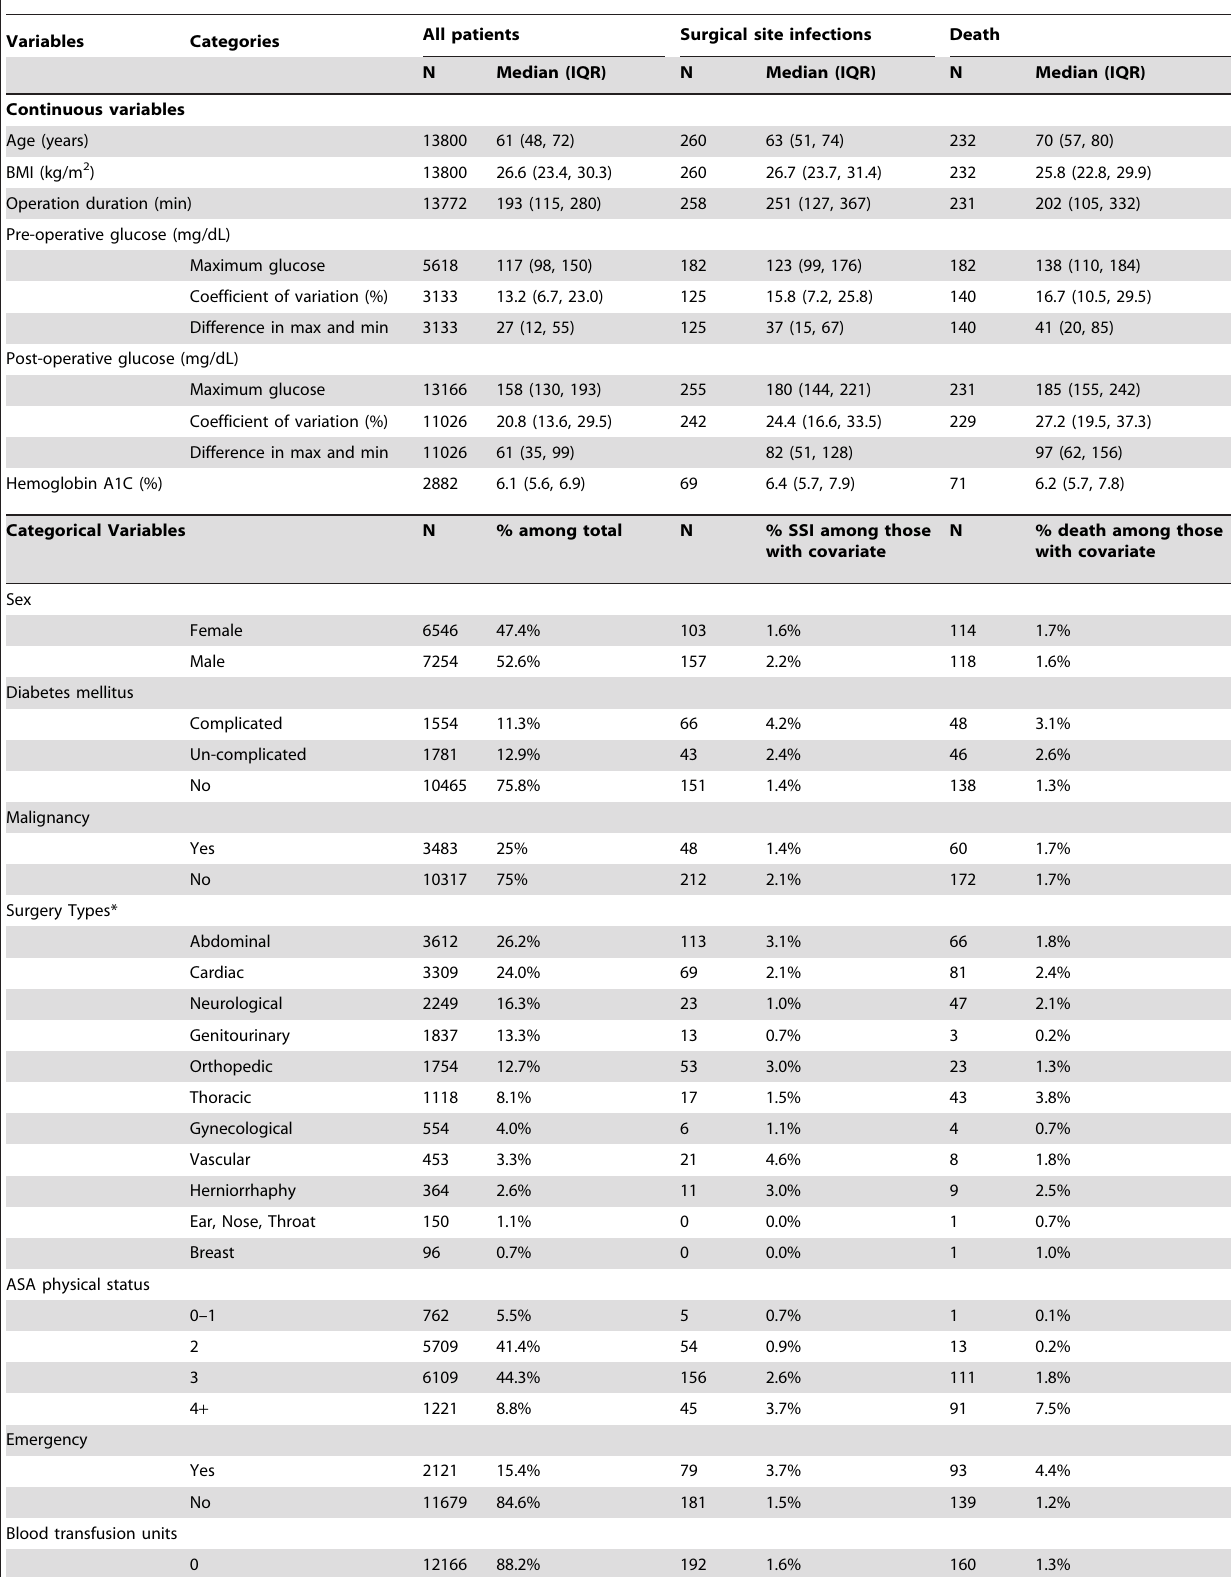
Table 1. Characteristics of patients who underwent surgical procedures by status of infection and in-hospital death.